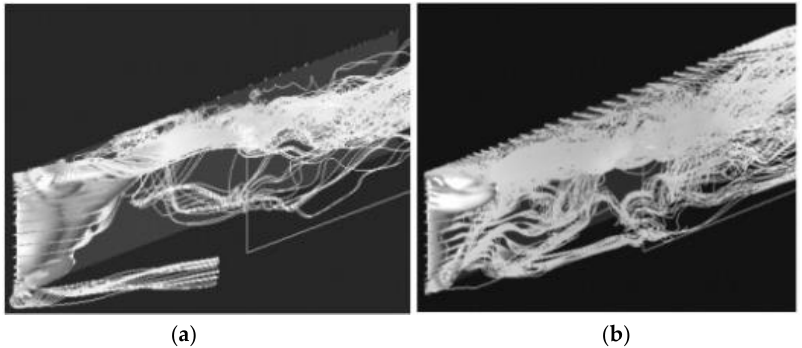
Figure 21. Comparison of cavitation structure and streamlines: ( a ) without tip clearance; ( b ) with tip clearance [45].